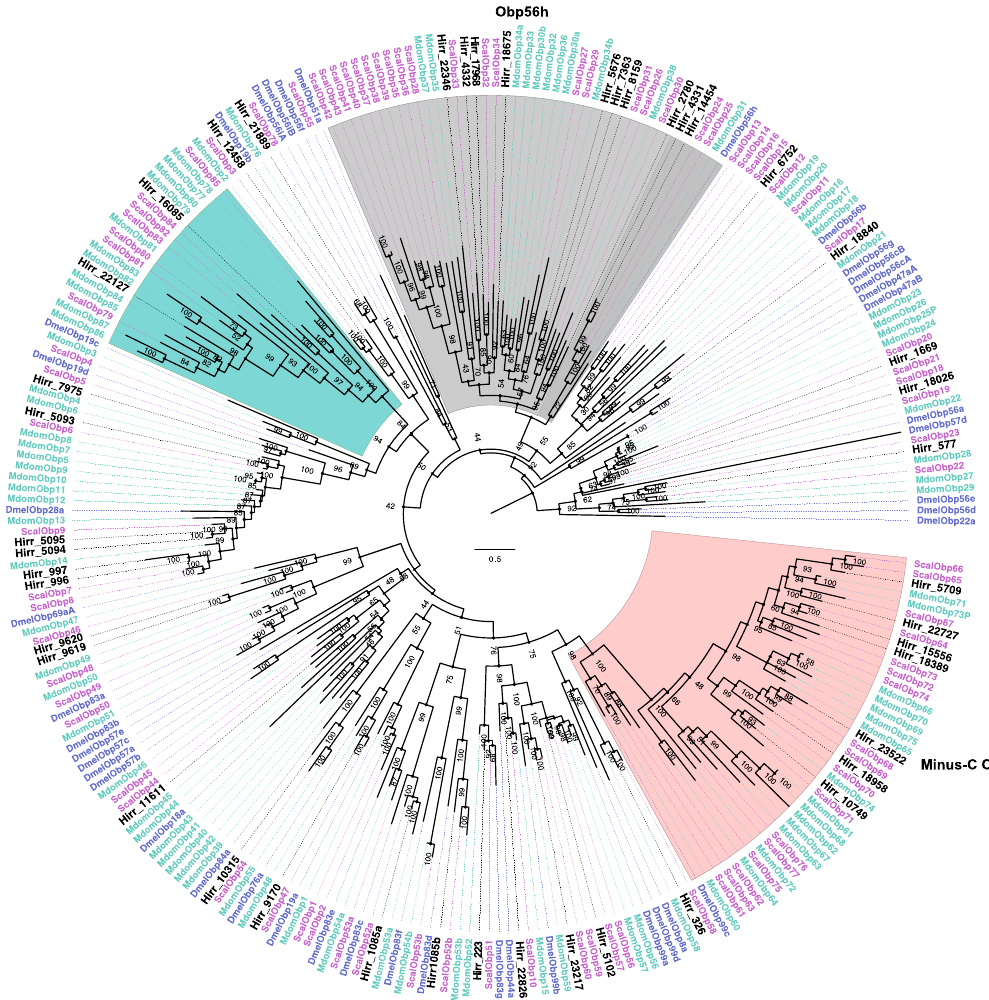
Figure 3. Phylogenetic relationship of Haematobia irritans candidate odorant binding proteins (OBP) with those of Stomoxys calcitrans , Musca domestica, and Drosophila melanogaster . The H. irritans (Hirr) genes are labeled in black, while the S. calcitrans (Scal) and M. domestica (Mdom) genes are labeled in pink and teal, respectively. D. melanogaster (Dmel) genes are labeled in purple. The Minus-C OBP lineage is shaded in pink, while the lineage with expansions relative to DmelObp56 h is shaded in grey. A lineage of muscid OBPs with no apparent orthologue in Drosophila is shaded in teal.